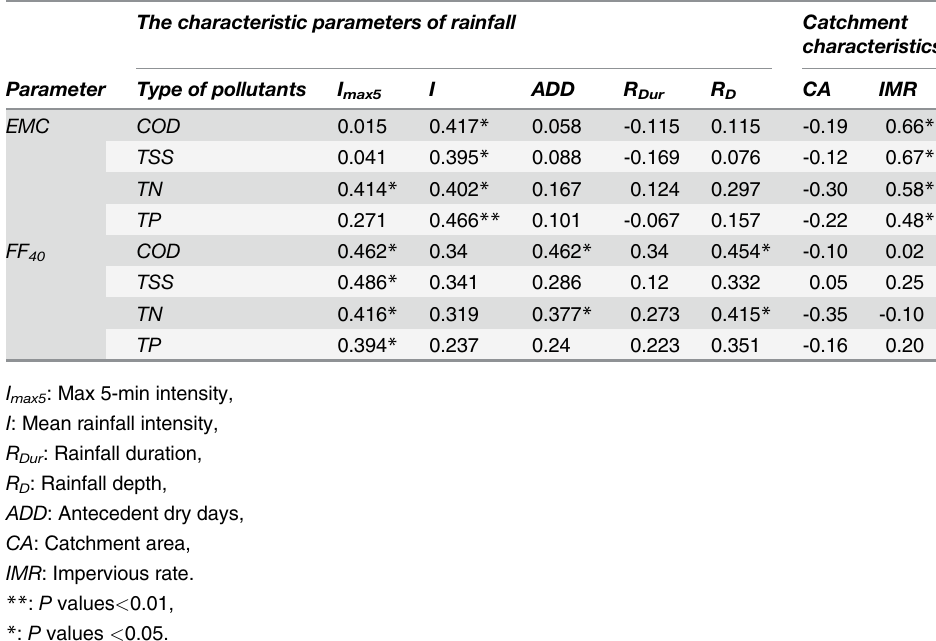
Table 5. Correlations between EMCs , FF 40 , rainfall and catchment